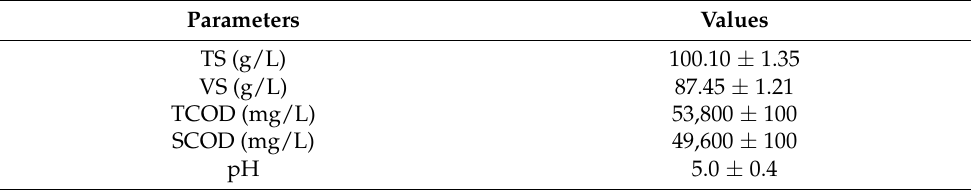
Table 1. Characterization of